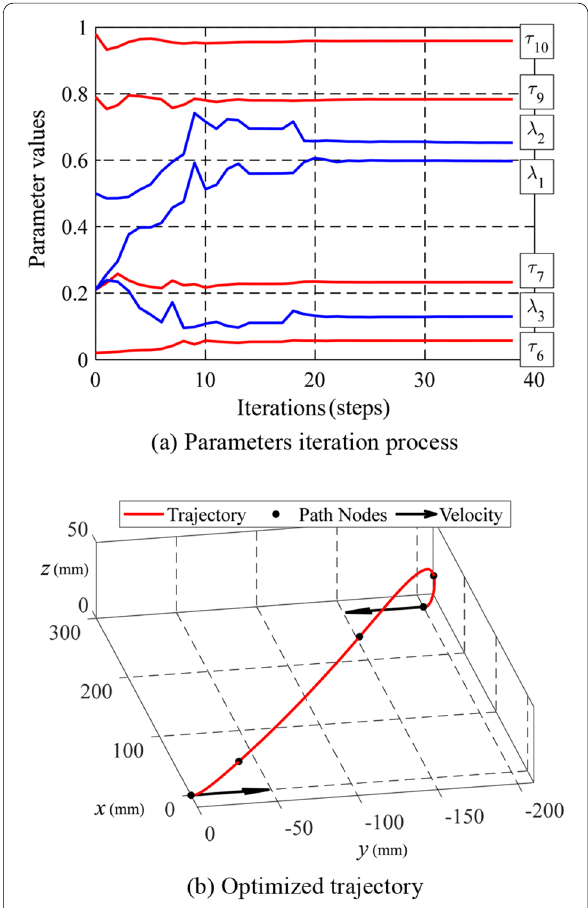
Figure 3 The optimization result of an example